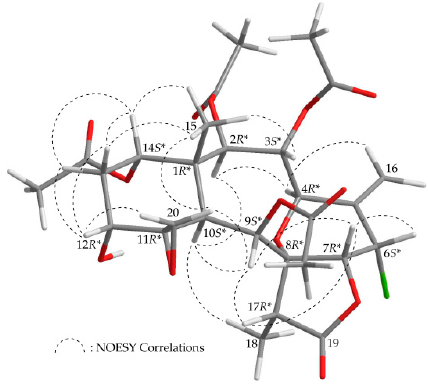
Figure 2. A model of 1 generated using a computer-assisted system based on the data from MM2 force field calculations and selected protons with key NOESY correlations.